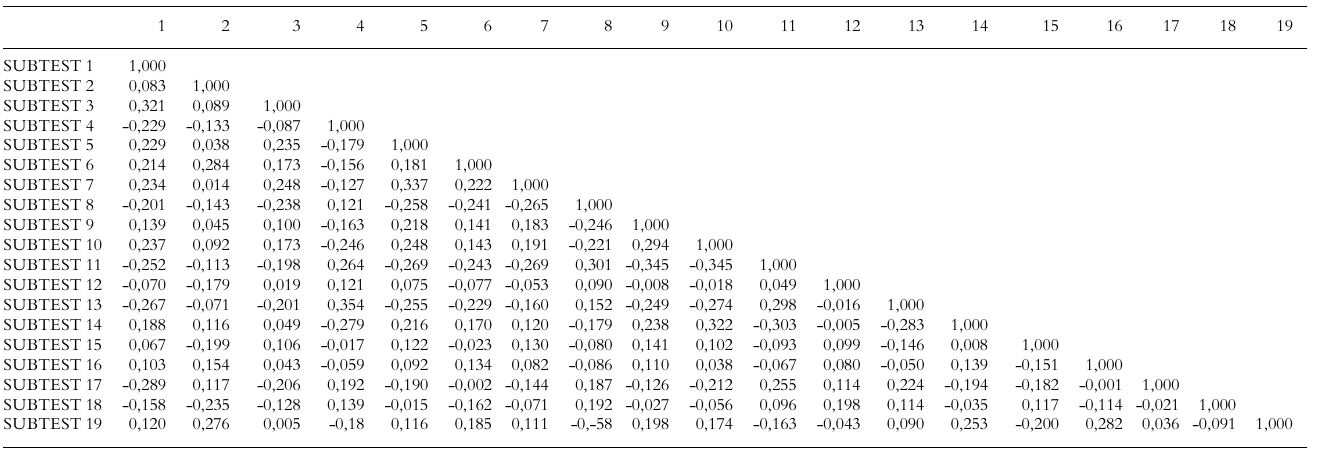
TABLE 3 MATRIXOF INTERCORRELATIONSOF SUBTESTSOF THE MORALREASONING